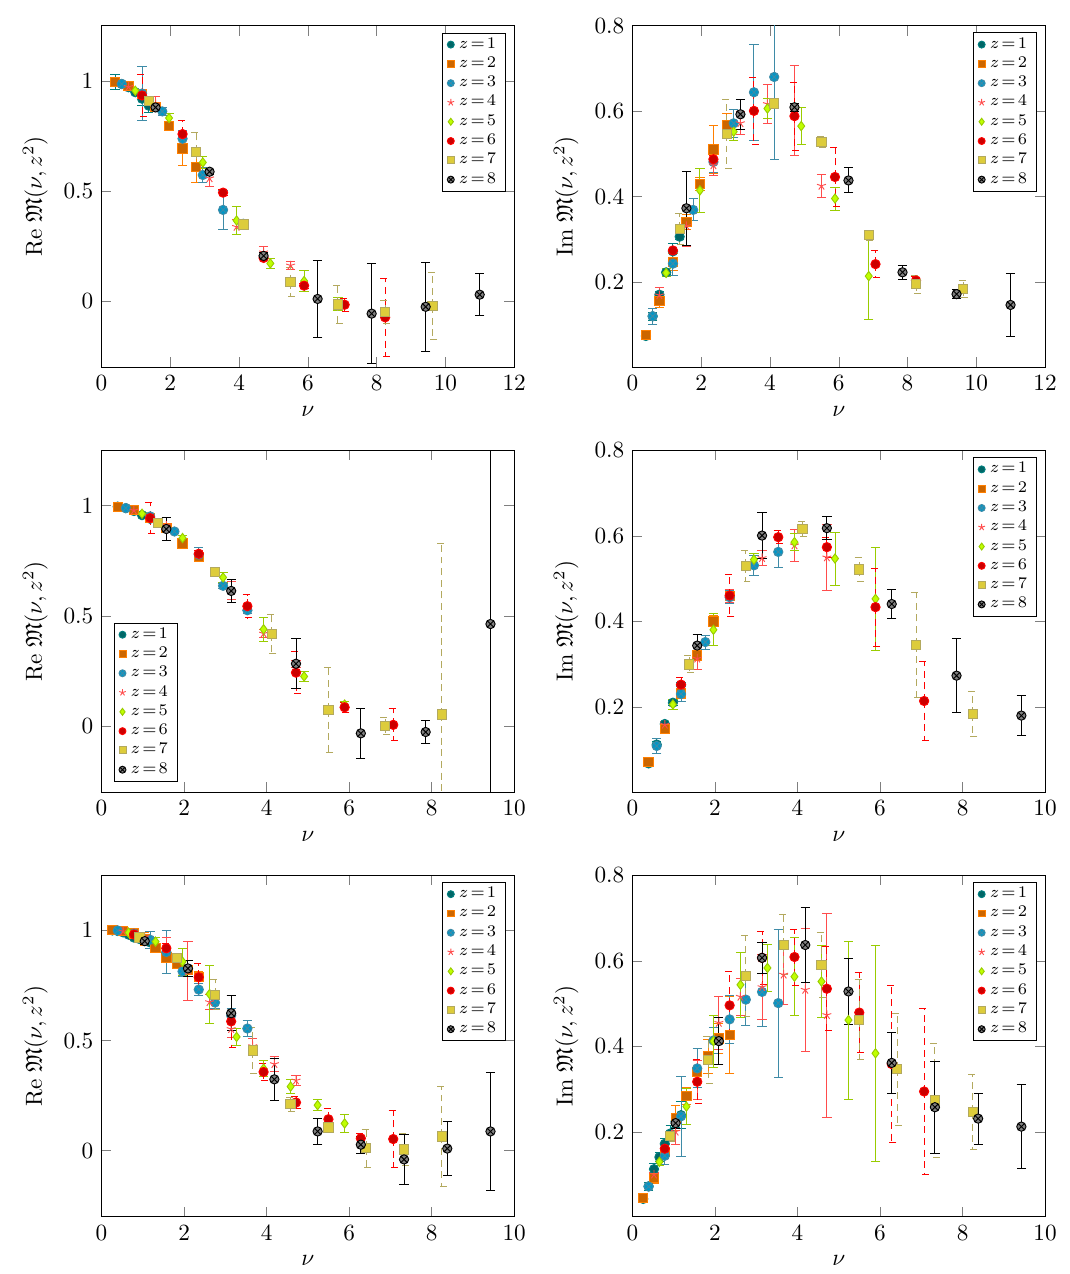
Figure 5 . The real (l.h.s.) and the imaginary (r.h.s.) part of the reduced ITDs. The first row contains the results of the coarsest ensemble e A 5 , the second row the results of the ensemble E 5 with the intermediate lattice spacing and the third row depicts the results for the ensemble N 5 with the finest lattice spacing. The statistical and systematic errors are added in